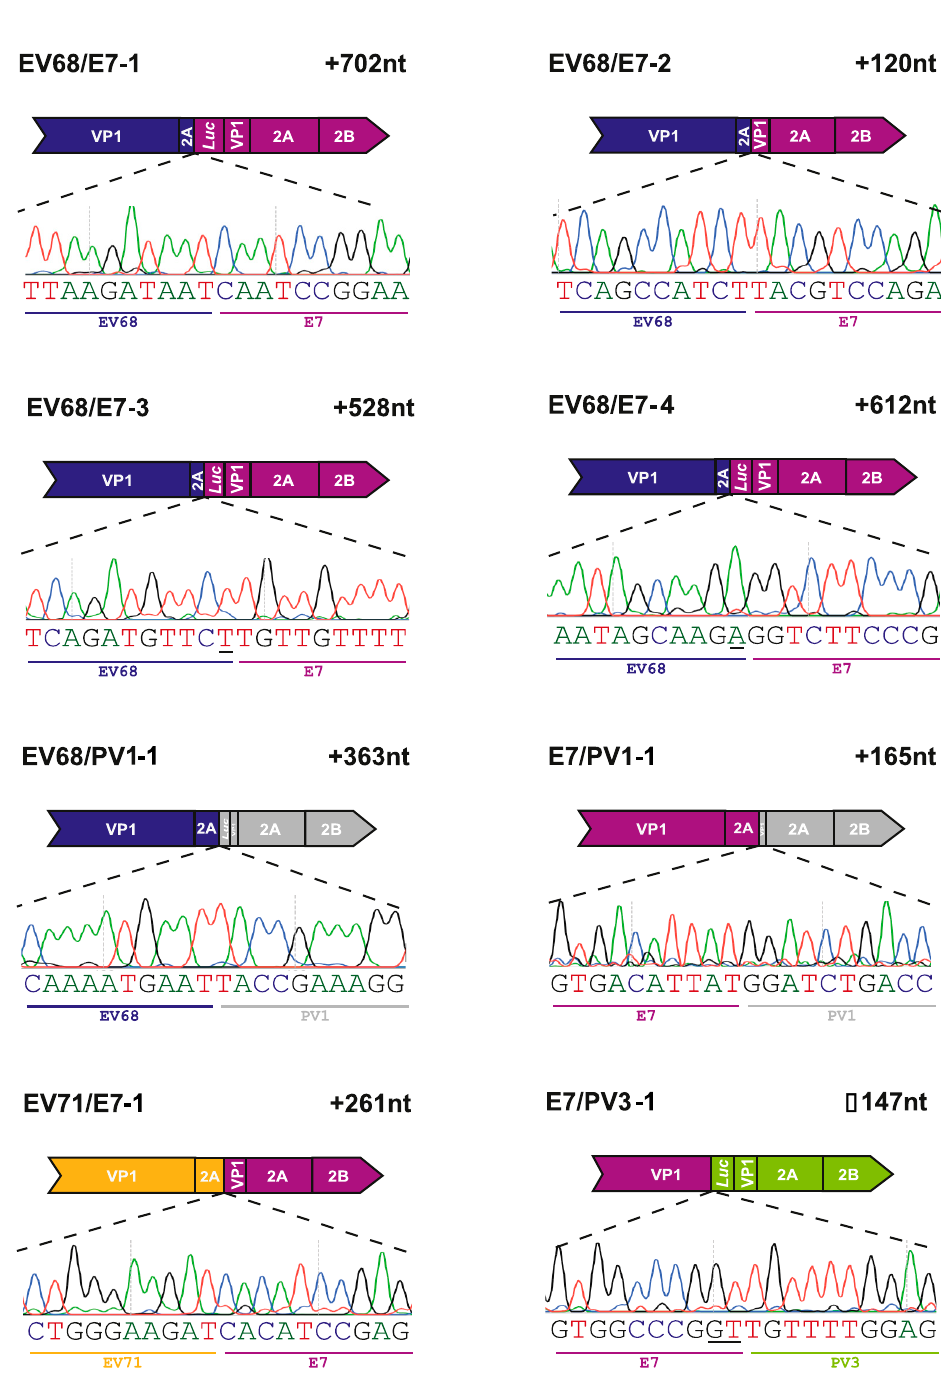
Figure 5. Recombinants isolated from inter-species CRE-REP assays. Schematic representation of each identified recombinant. Labelling and presentation are as described in Figure 4B.